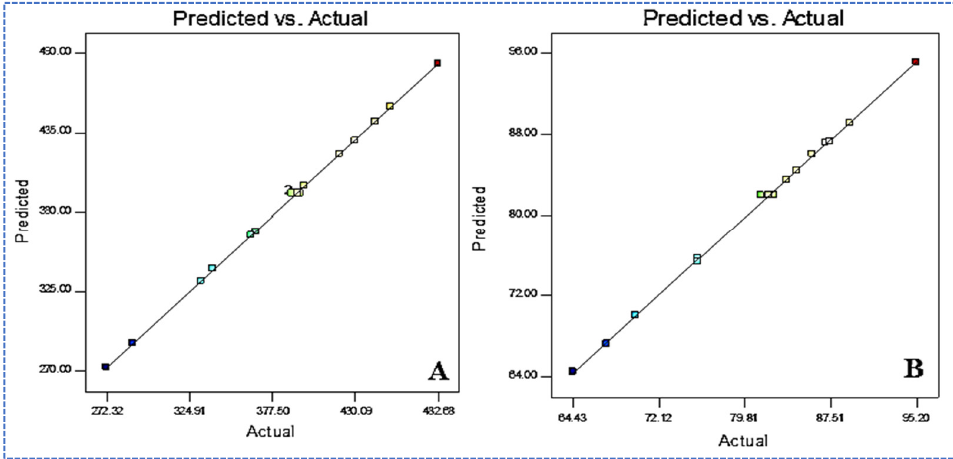
Figure 3. Actual and predicted image of ( A ). hydrodynamic diameter and ( B ). entrapment efficiency.